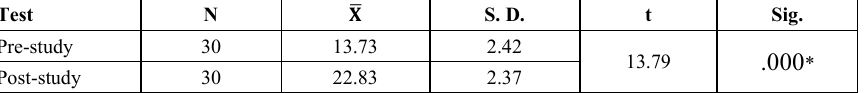
Digital Access and Awareness